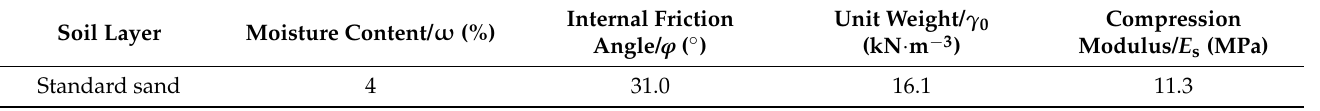
Table 1. Basic physical and mechanical parameters of the soil